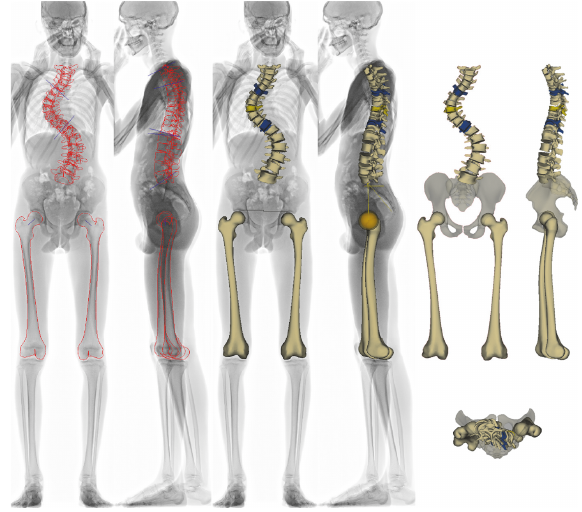
Figure 1: SterEOS 2D/3D spine, pelvis, and femur 3D reconstruc- tion (from our